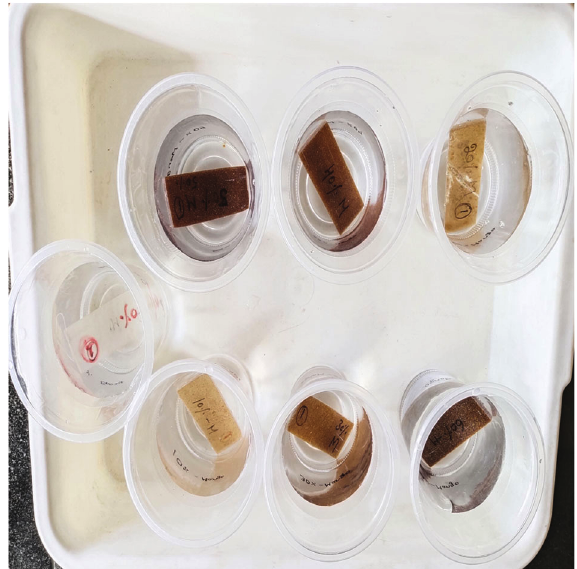
Figure 6: Samples immersed in distilled